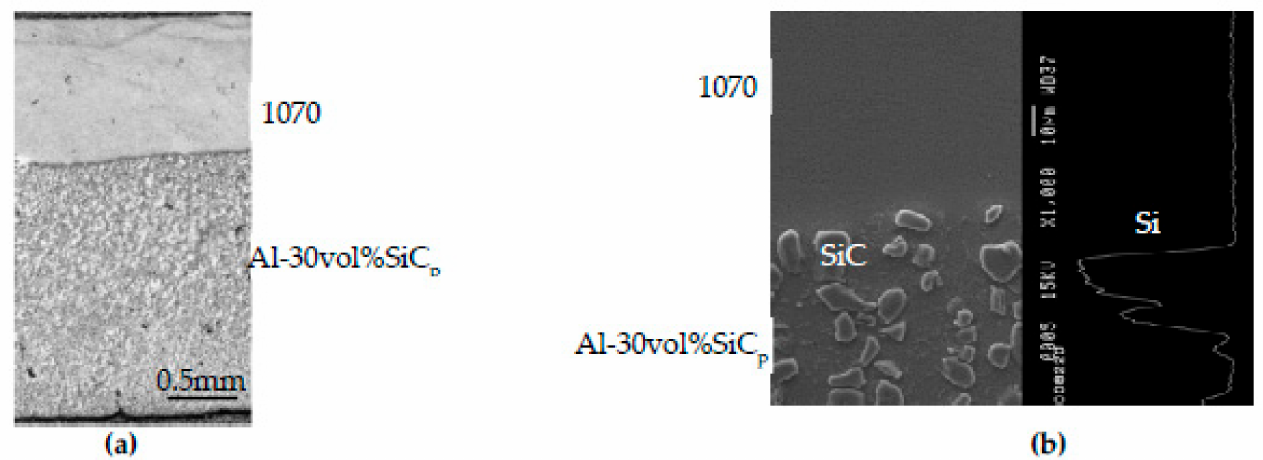
Figure 23. Cross-section of clad strip consisting of a 1070 base strip and an Al-30vol%SiC p overlay strip, and the result of a line analysis of Si at the interface between strips. ( a ) Cross-section of clad strip. ( b ) Line analysis of